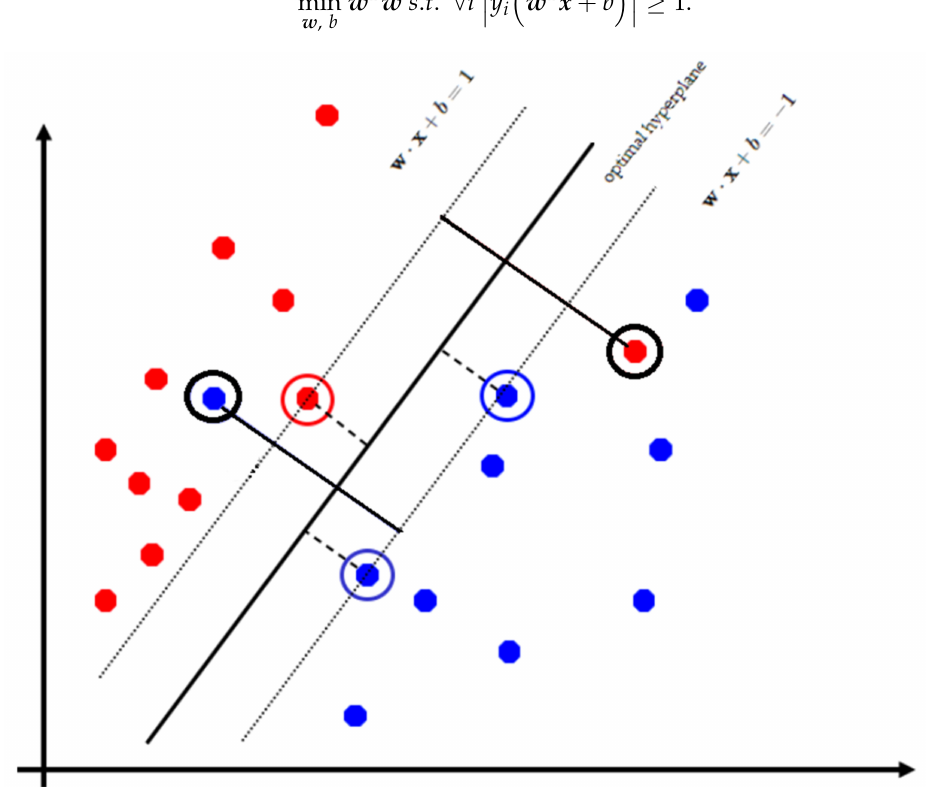
Figure 4. The SVM functions here as a linear binary classifier. The data belonging to either the positive or negative class are plotted, and the optimal boundary between them clearly separates each class. The support vectors used to draw this boundary are centered in a circle of their relevant class color, while examples that violate the slack constraint are circled in